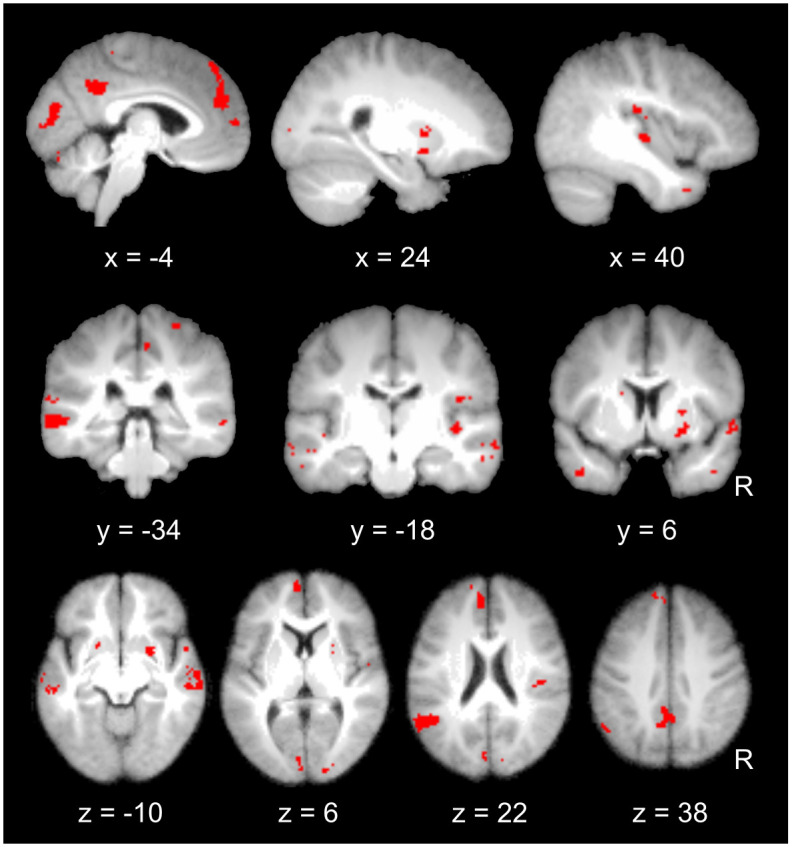
Overlap between brain activation patterns associated with synchronization between emotion components estimated by the brain-based synchronization and the model-based synchronization indices.Effects are presented on sagittal, coronal, and axial slices of a mean image created by averaging the participants’ normalized structural images. Individual beta maps used for this figure are available on Neurovault at https://identifiers.org/neurovault.collection: 8740.